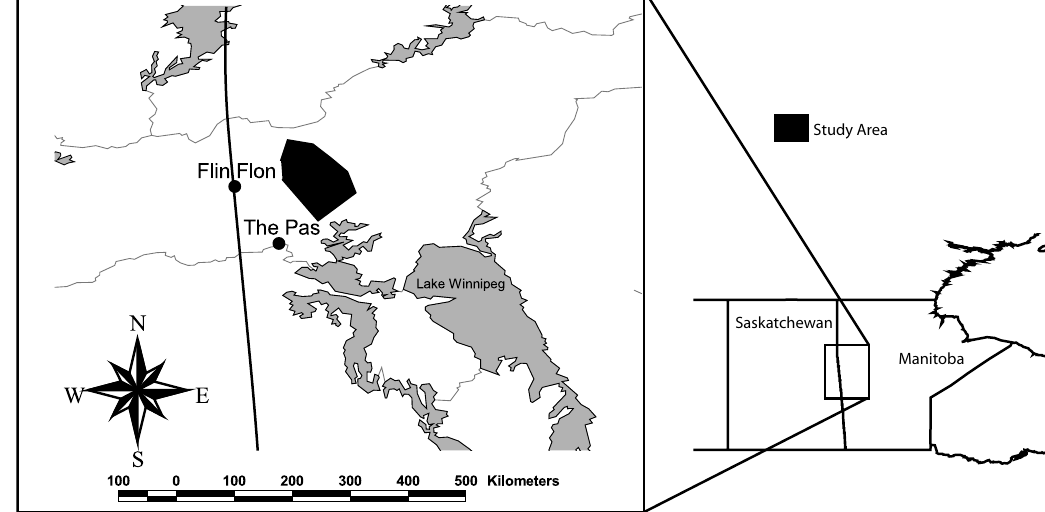
Fig. 1. The location of the Naosap caribou range in west-central Manitoba,